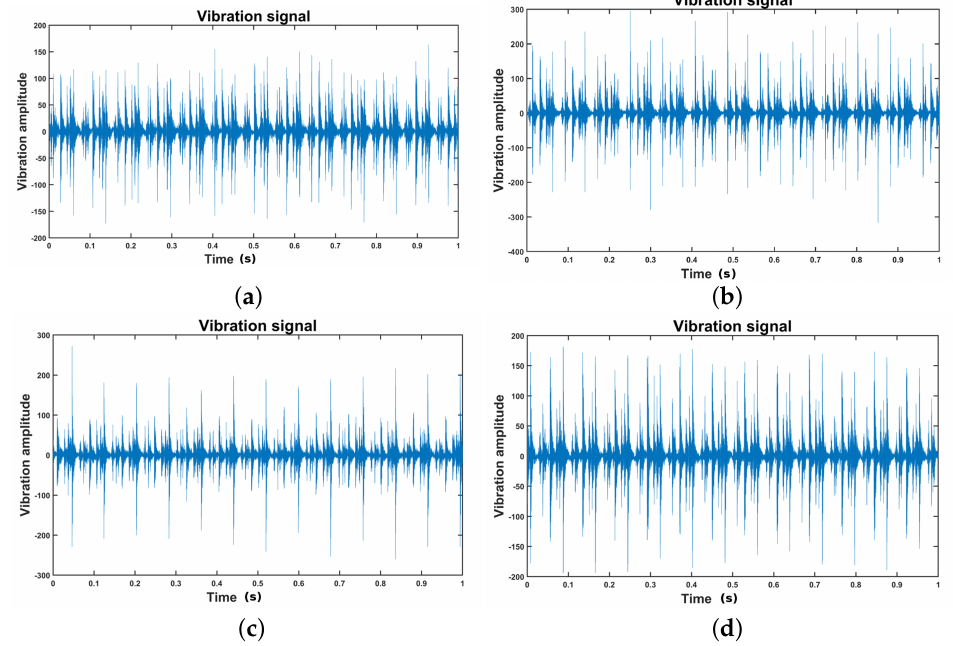
Figure 8. Vibration signals from the RC dataset. ( a ) Signal from the class P1, ( b ) signal from class P6, ( c ) signal from class P11, ( d ) signal from class P16.